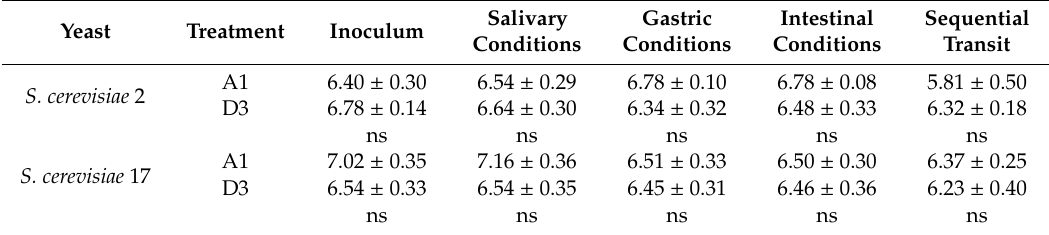
Table 4. Viable count of US-treated S. cerevisiae 2 and S. cerevisiae 17 after simulated gastrointestinal transit. Mean values ± standard deviation. A1, untreated microorganism; D3, 20% of the net power,